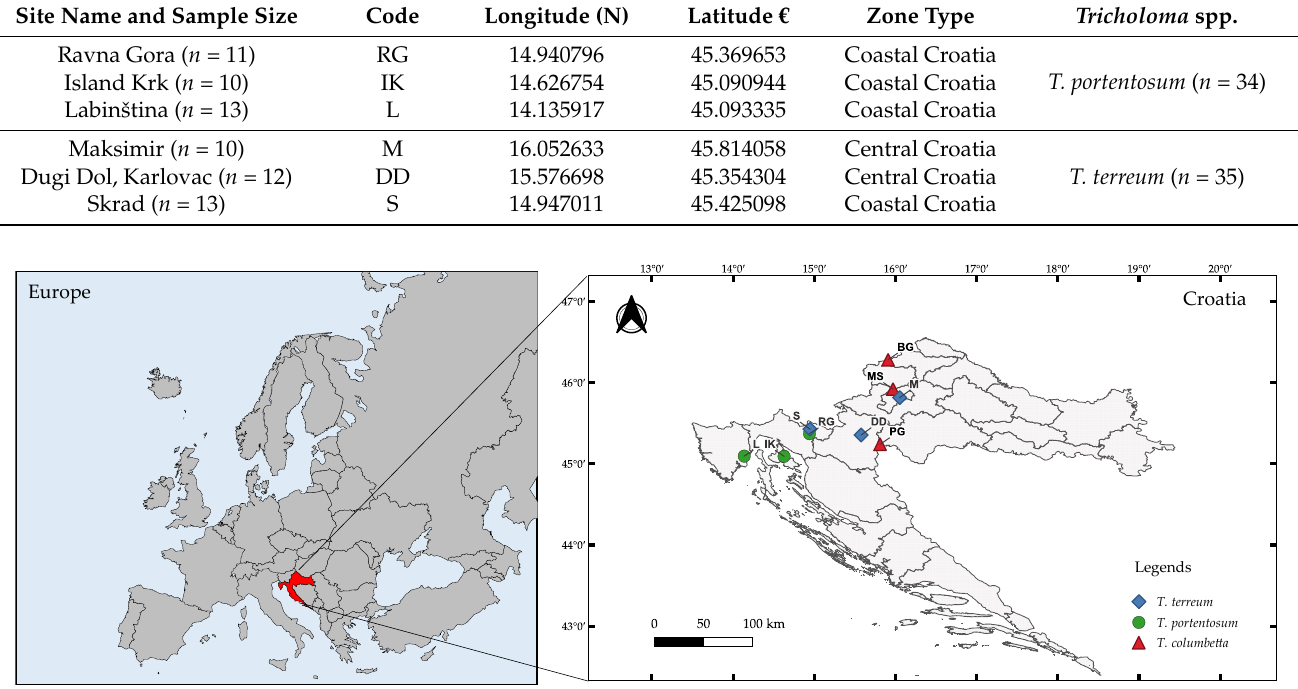
Figure 1. Map of the Tricholoma spp. mushroom sample collection sites across Croatia.